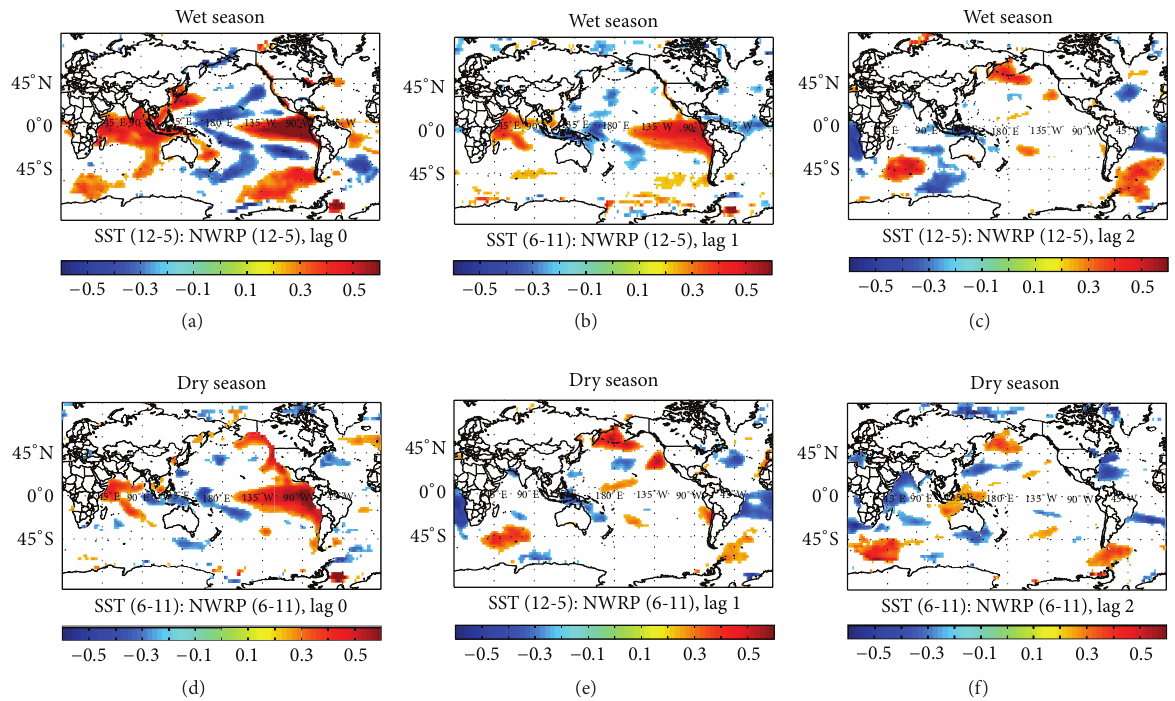
Figure 3: Correlation coefficient maps between SST and NWRP for wet (a, b, and c) and dry (d, e, and f) and different season lags.